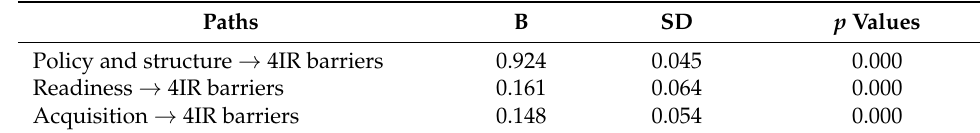
Table 7. Hypotheses, SD, and p values for the model.